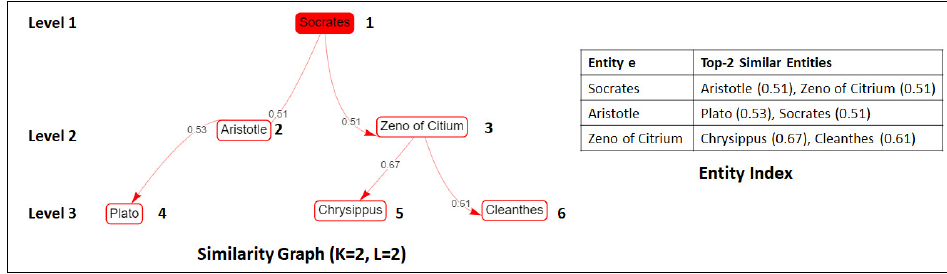
Figure 6. Constructing the Similarity Graph for “Socrates” with parameters K = 2 and L = 2.